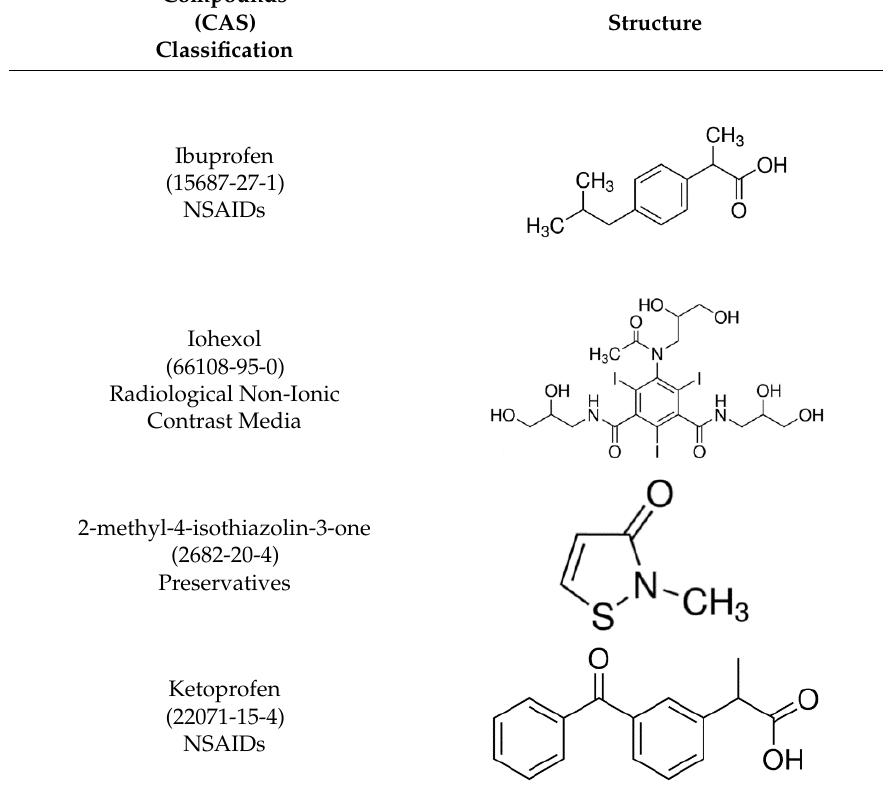
Table 2. The removal efficiency of PPCPs by combining biological treatment with other processes.